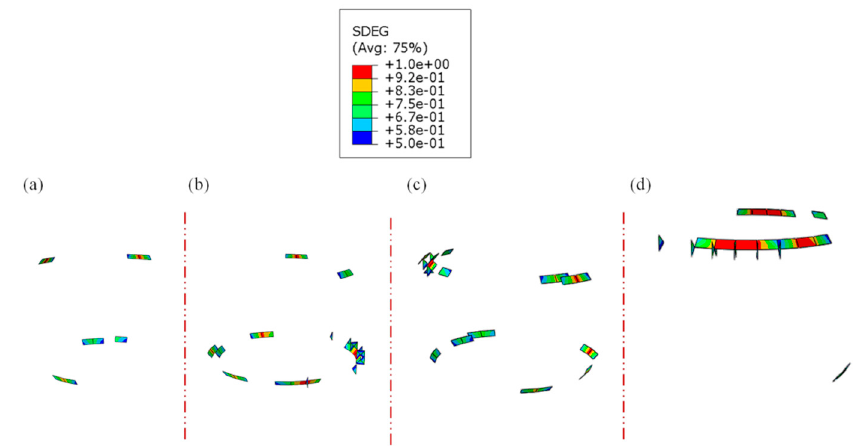
Figure 10. Fatigue damage patterns under 8936 N, ( a ) No. 1, ( b ) No. 2, ( c ) No. 3, and ( d ) No. 4.